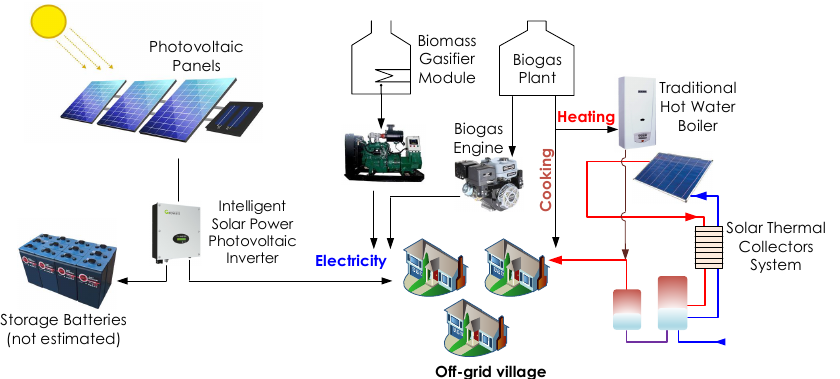
Figure 5. SIRES configuration obtained from the optimization model.